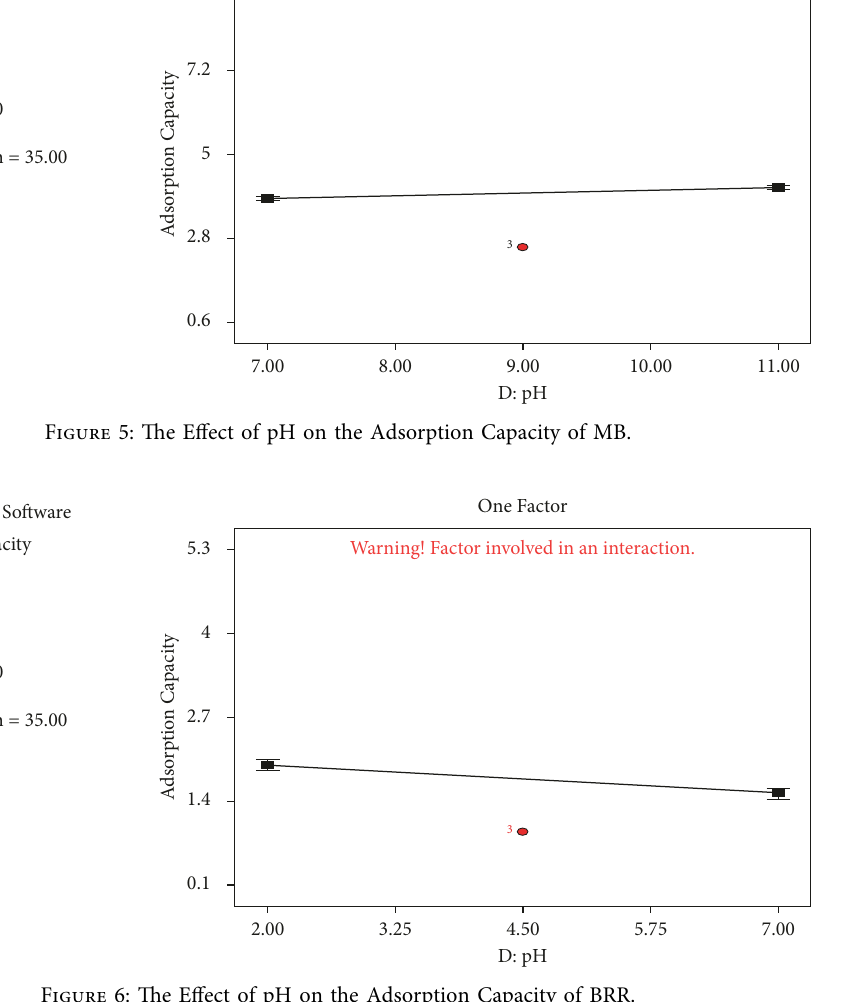
Figure 6: The Effect of pH on the Adsorption Capacity of